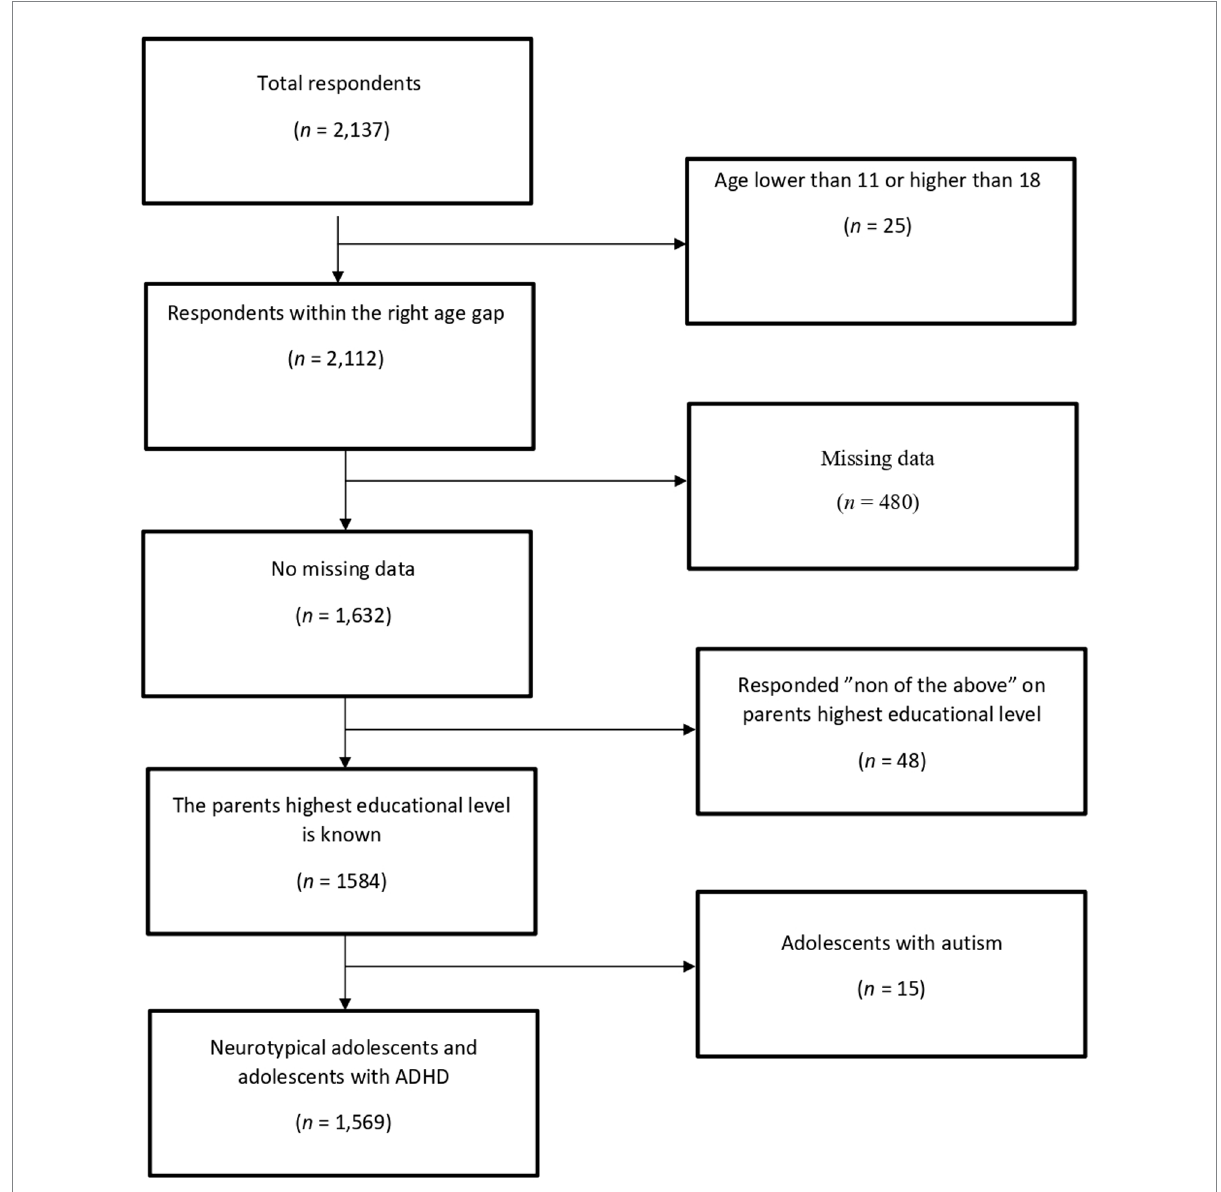
FIGURE 1 The process for the exclusion of the sample. The squares on the right side indicates the participants that were excluded from our analyses and the reason for their exclusion. The squares on the left side indicates the total sample left after the exclusion. The total sample for the study was